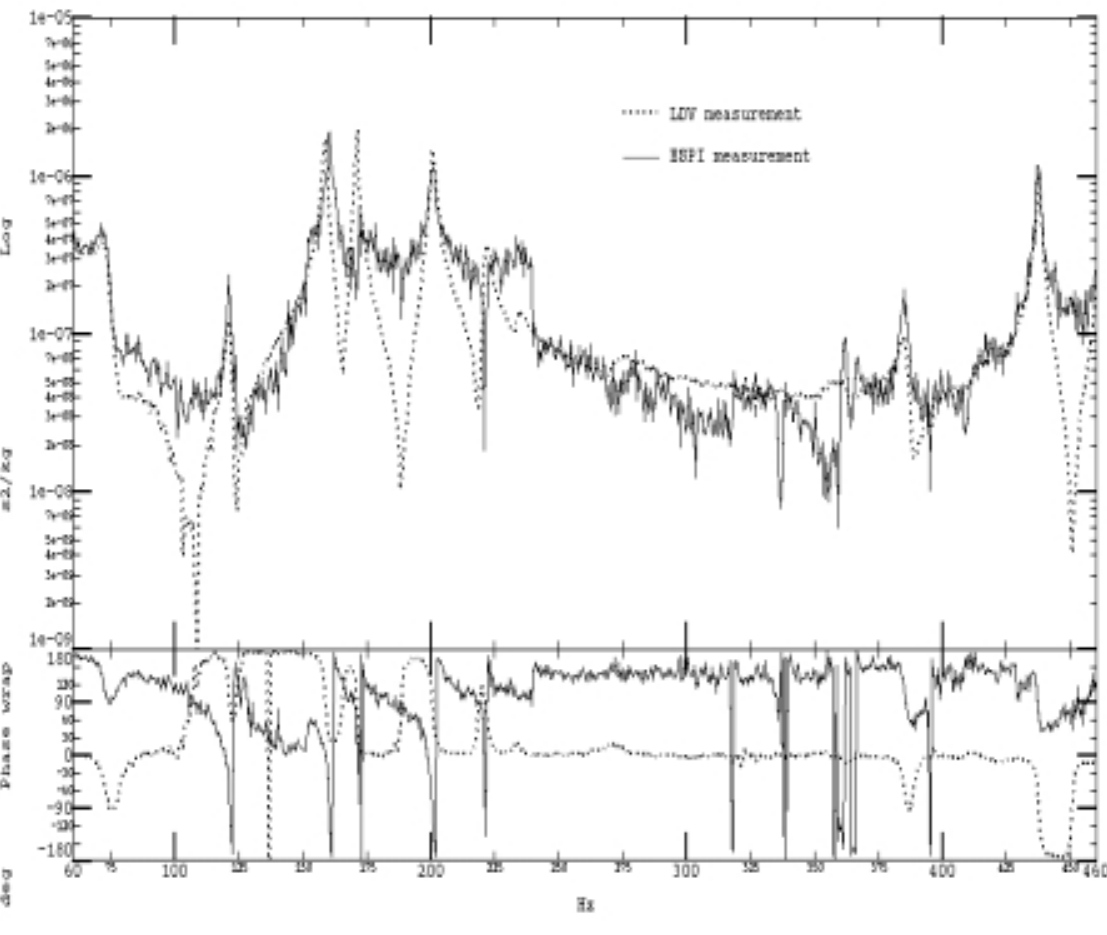
Fig. 9. FRF of a low response point measured with ESPI and LDV (dotted